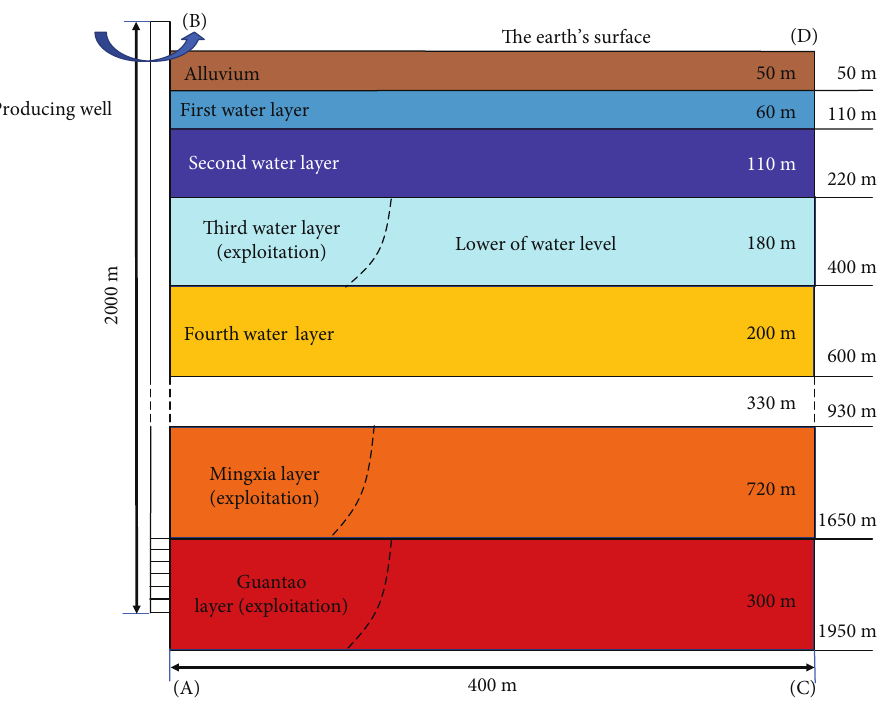
Figure 3: Schematic diagram of aquifer settlement.